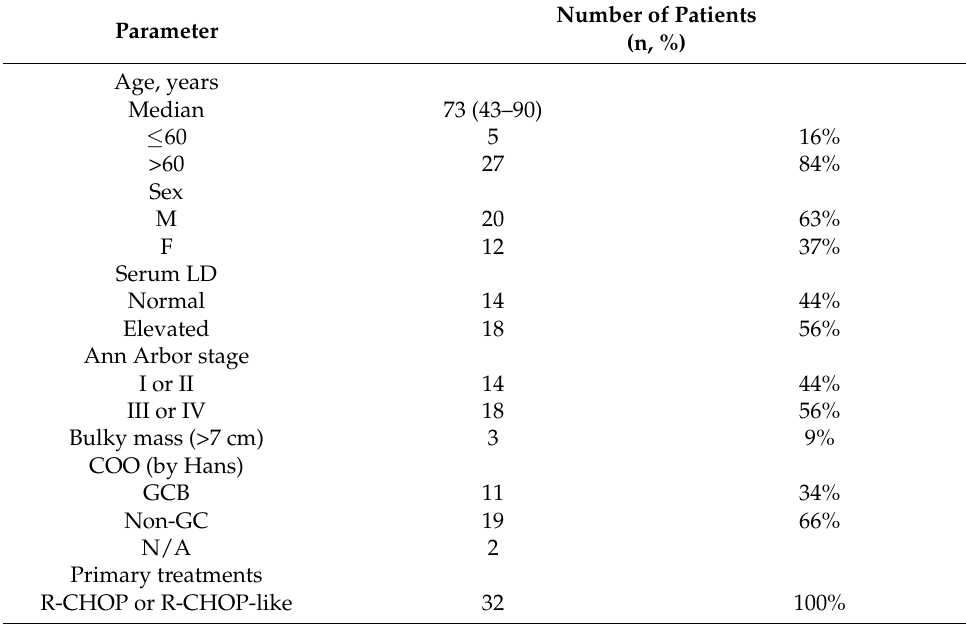
Table 1. Patient